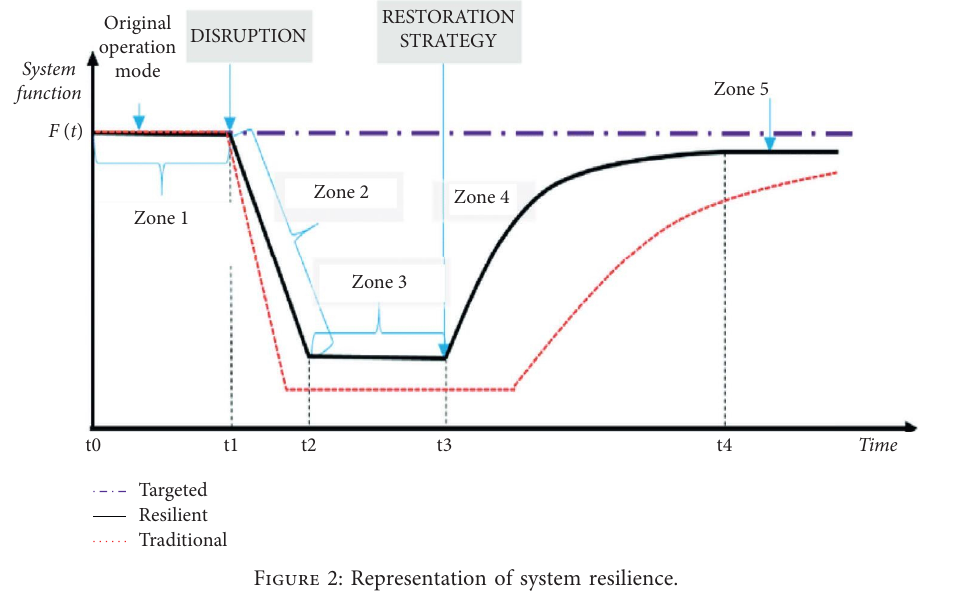
Figure 2: Representation of system